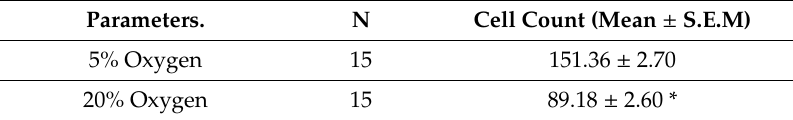
Figure 4. Embryo quality scoring. Physiological oxygen improved the quality of blastocysts, as indicated by lower percentage of low score blastocysts and higher proportionate of high score blastocysts. Asterisk (*) indicates the significant difference ( p < 0.05) between the groups.